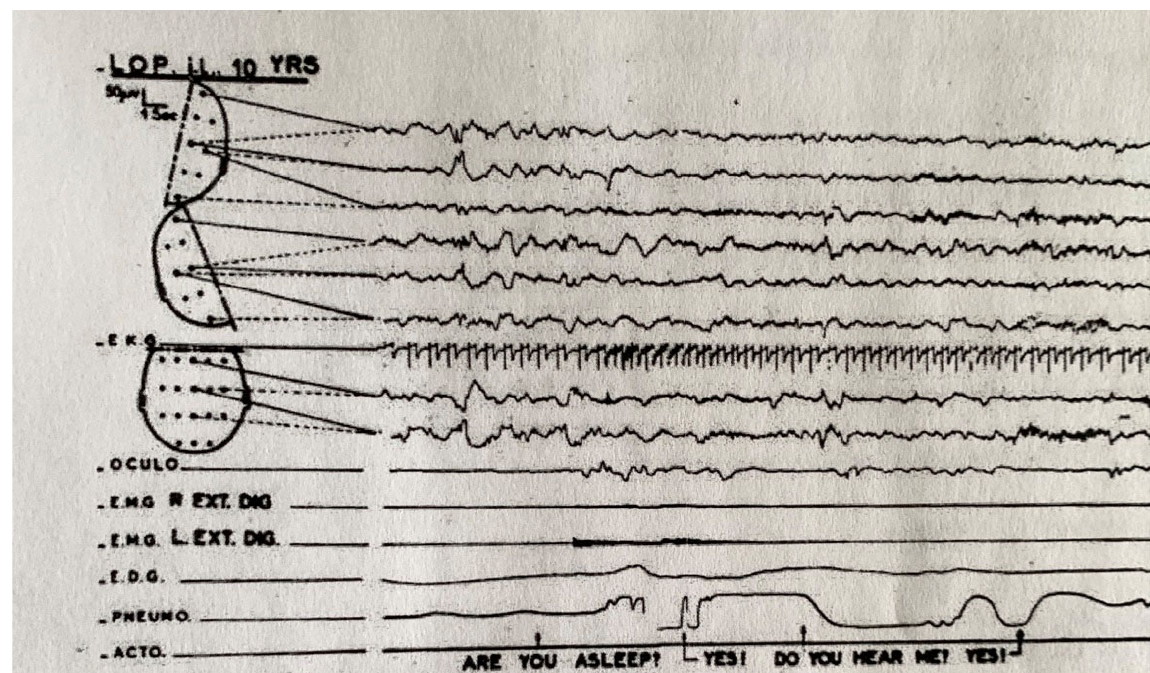
Figure 19. An episode of sleep talking in a child in NREM sleep. The investigator asks, “Are you asleep?” and the child answers “yes”. Later the investigator asks, “do you hear me?” and the child responds “yes”. Each time that a question is asked there is an evoked k ‐ complex and each time the child answers there is a brief arousal response. Therefore, the child has heard the questions, understood them, and answered appropriately. (Adapted from Gastaut, H. and Brough ‐